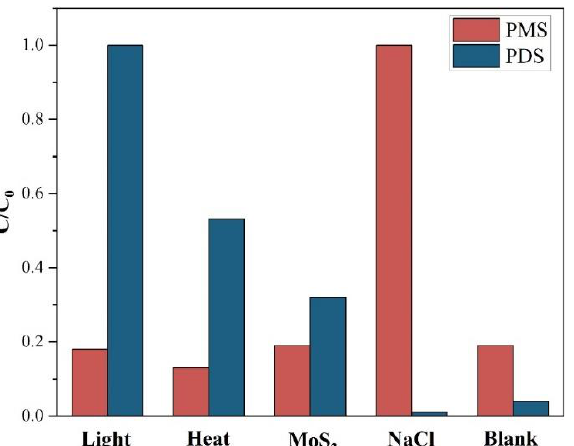
Figure 5. Contribution of each factor to the activation of PMS and PDS. Experimental conditions: [Phenol] 0 = 1 mg/L, [PMS] = 1 mmol/L, [PDS] = 1 mmol/L, solar intensity = 1 kW/m 2 , T = 42.2 °C, [salinity] = 3.5 wt% NaCl, [MoS 2 ] = 0.88 g/L.